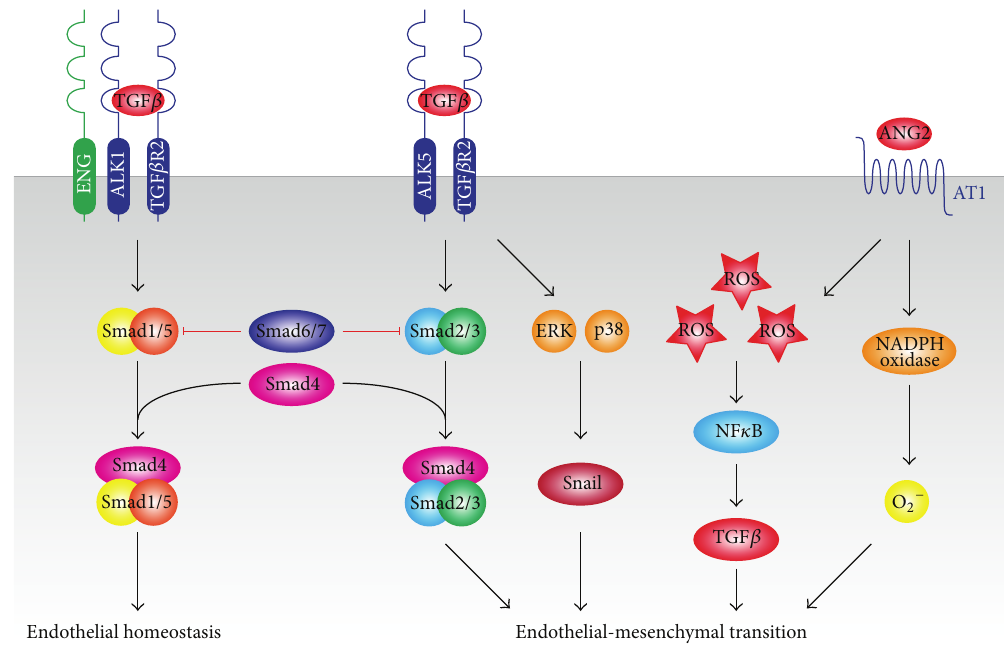
Figure 1: Mechanisms of endothelial-mesenchymal transition. EndMT is induced by TGF 𝛽 -dependent and TGF 𝛽 -independent mechanisms. Canonically, TGF 𝛽 -induced activation of SMAD2/3 induces the expression of mesenchymal genes and repression of endothelial genes. Noncanonically, TGF 𝛽 -induced activation of Erk1/2 and p38 MAPK activate the transcription factor Snail which induces mesenchymal differentiation and inhibits VE-Cadherin expression. Inflammatory signals and increased ROS production facilitate EndMT by increasing endogenousTGF 𝛽 expression,inanNF 𝜅 B-dependentmanner,creatingafeedforwardsignalingmechanism.AT1receptorcaninduceEndMT through activation of NADPH oxidase, resulting in increased ROS production and reduction of eNOS expression and